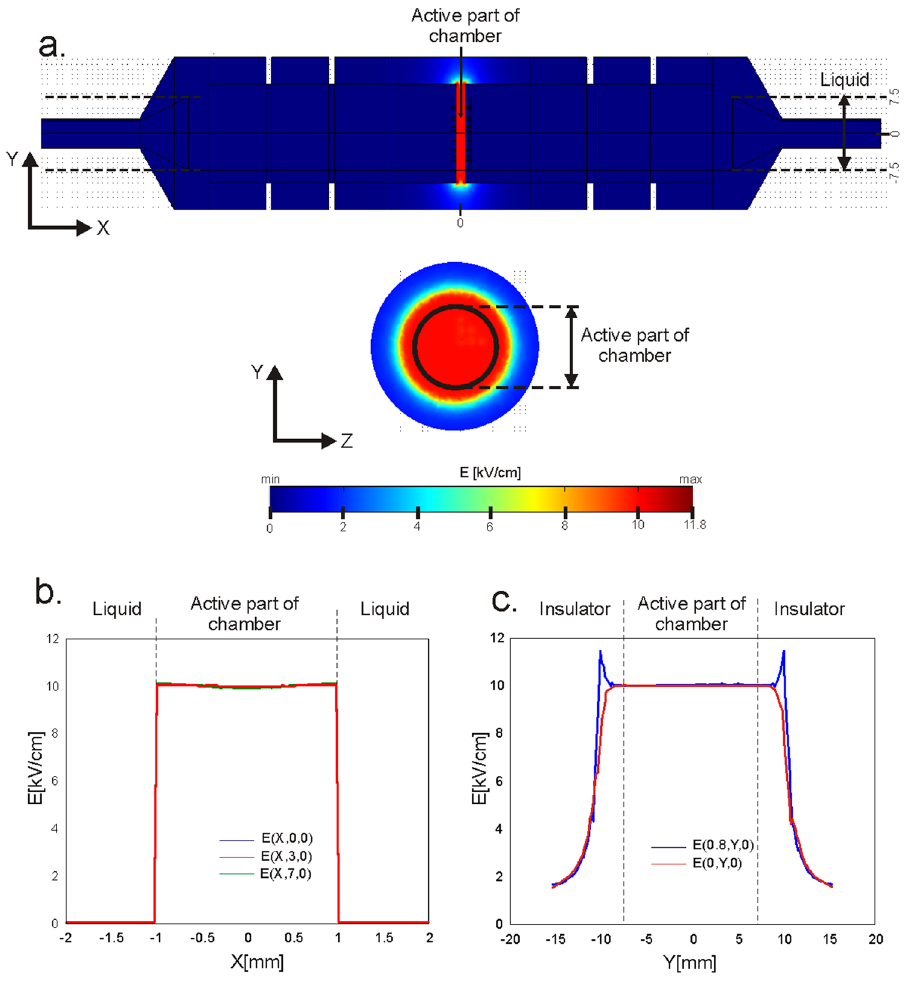
Figure 5. Calculated electric field distribution within the treatment chamber ( a ) in XY and YZ cross section plane, ( b ) along X axis and ( c ) along Y